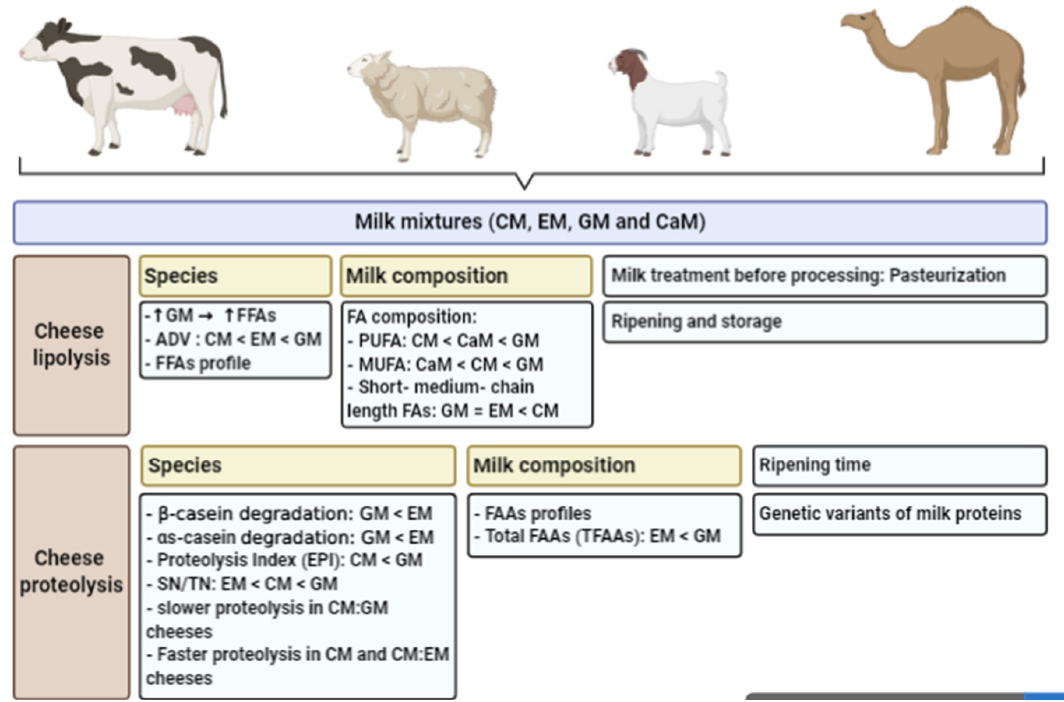
Figure 1. Overview of milk species and milk mixtures on cheese lipolysis and proteolysis. CM: cow milk; EM: ewe milk; GM: goat milk; CaM: camel milk; FAAs: free amino acids; TFAAs: total free amino acids; SN: soluble nitrogen; TN: total nitrogen; FFA: free fatty acids.